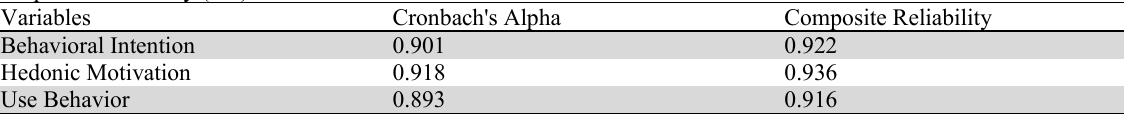
Composite Reliability (CR)